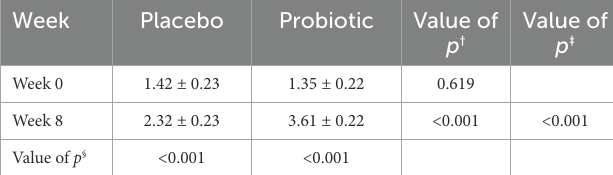
<0.001 <0.001 <0.001 Values are LSmean ± SE (all such values). † Student’s t -test was used to compare differences between the groups. ‡ Linear mixed-effect model adjusted with total volatile sulfur compound, alcohol drinker and alcohol amount at baseline was used to analyze the effects of group * week. § Linear mixed-effect model adjusted with total volatile sulfur compound, alcohol drinker and alcohol amount at baseline was used to analyze the difference within each